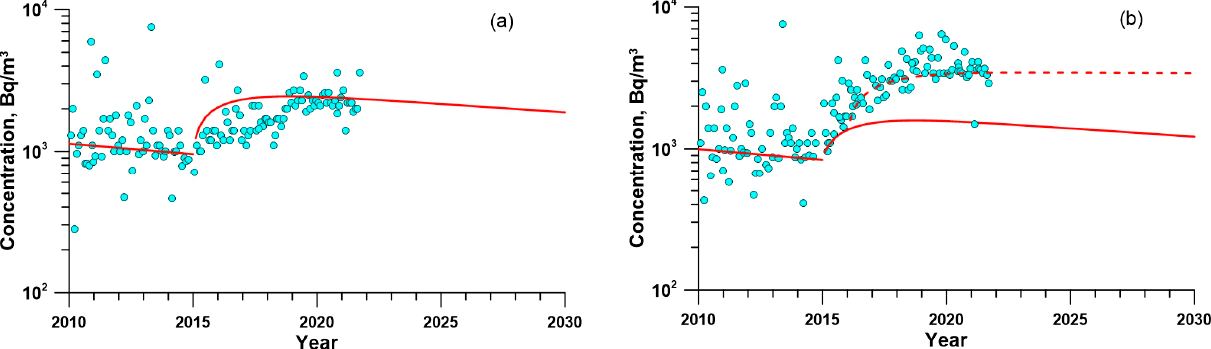
Figure 10. Changes in 90 Sr concentration in the water in Sector 5 ( a ) and Sector 8 ( b ). Dashed line corresponds to the scenario with an additional source of 90 Sr equal to 3 GBq/y after water level draw-down.